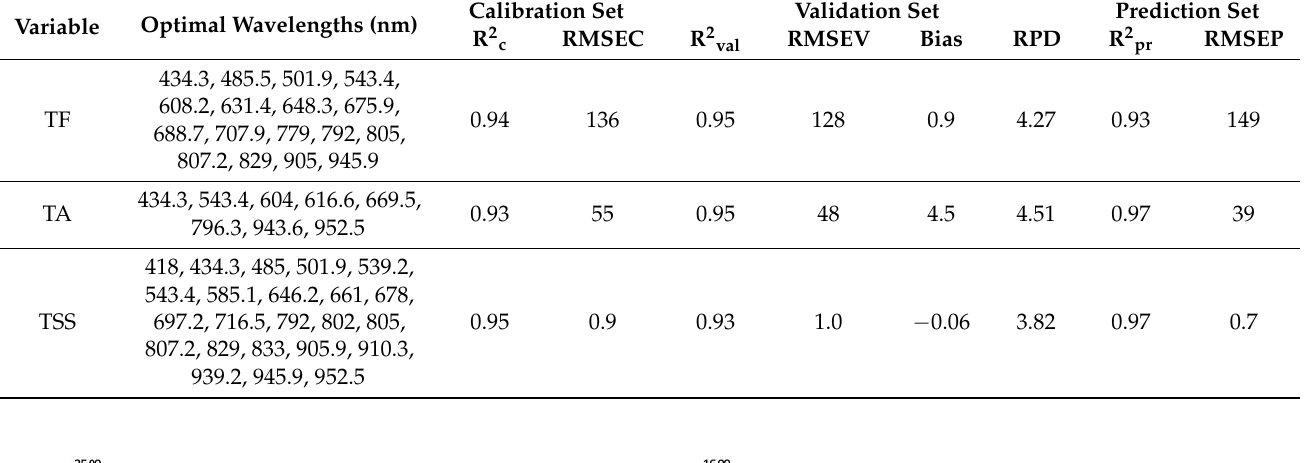
Table 3. Multiple Linear Regression (MLR) model performance for Total Flavonoids (TF), Total Anthocyanins (TA) and